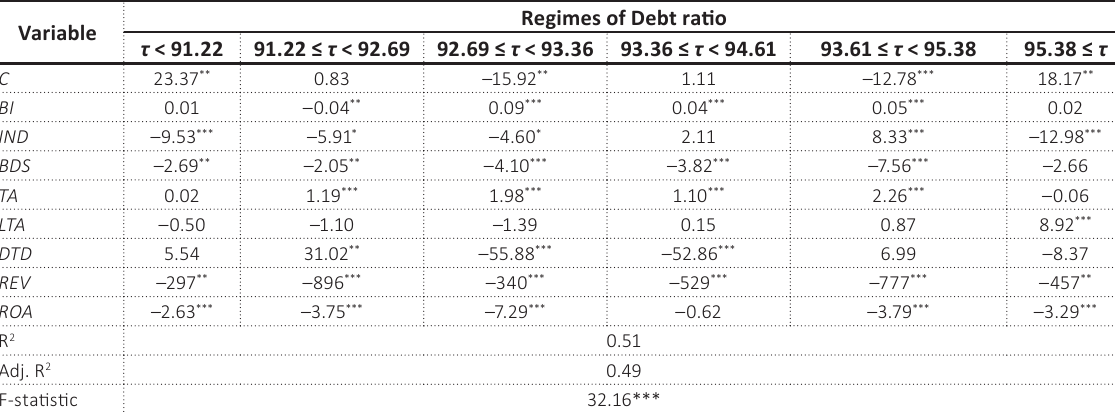
Table 5. Nonlinear effects on the capital adequacy ratio (CAR)